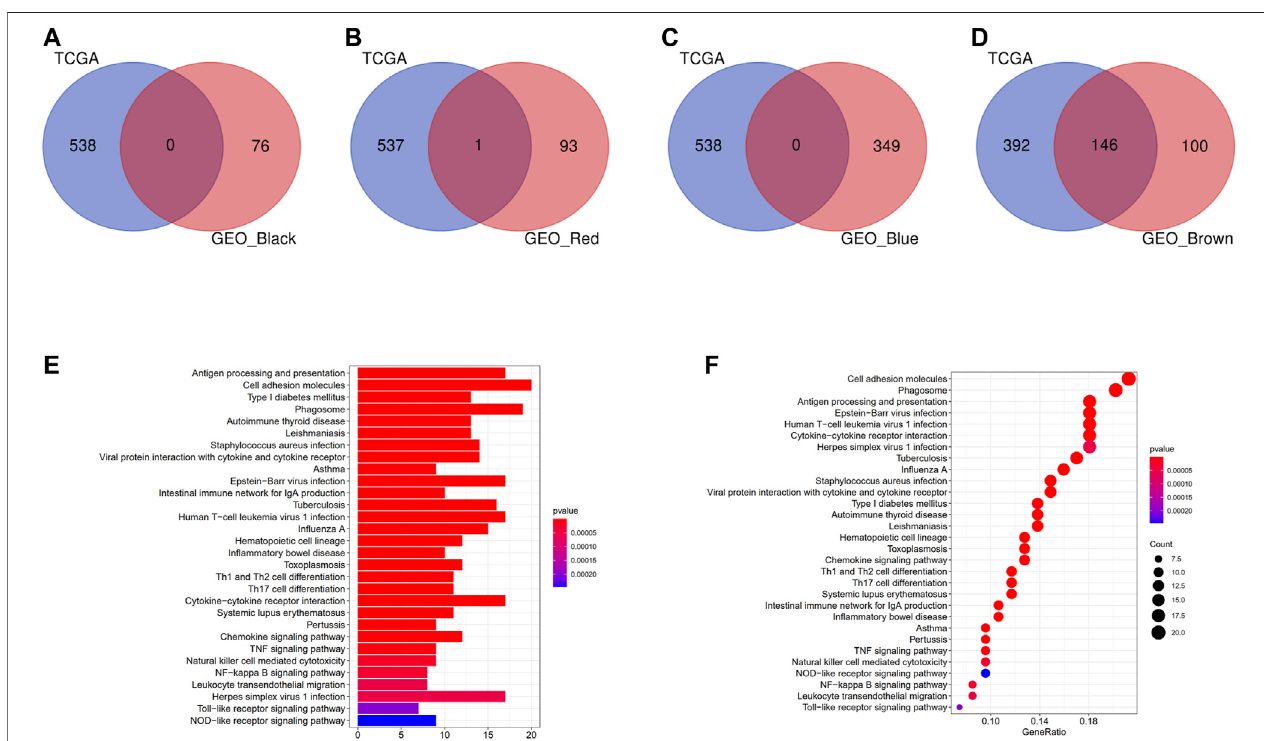
FIGURE 4 | Identi fi cation of hub modules correlated with DCs in fi ltration. (A) Intersection of the brown module (TCGA) and black module (GSE14520). (B) Intersection of the brown module (TCGA) and red module (GSE14520). (C) Intersection of the brown module (TCGA) and blue module (GSE14520). (D) Intersection of the brown module (TCGA) and brown module (GSE14520). (E) Barplot of KEGG pathway enrichment analysis in the 146 overlapping genes. (F) Bubble plot of KEGG pathway enrichment analysis in the 146 overlapping